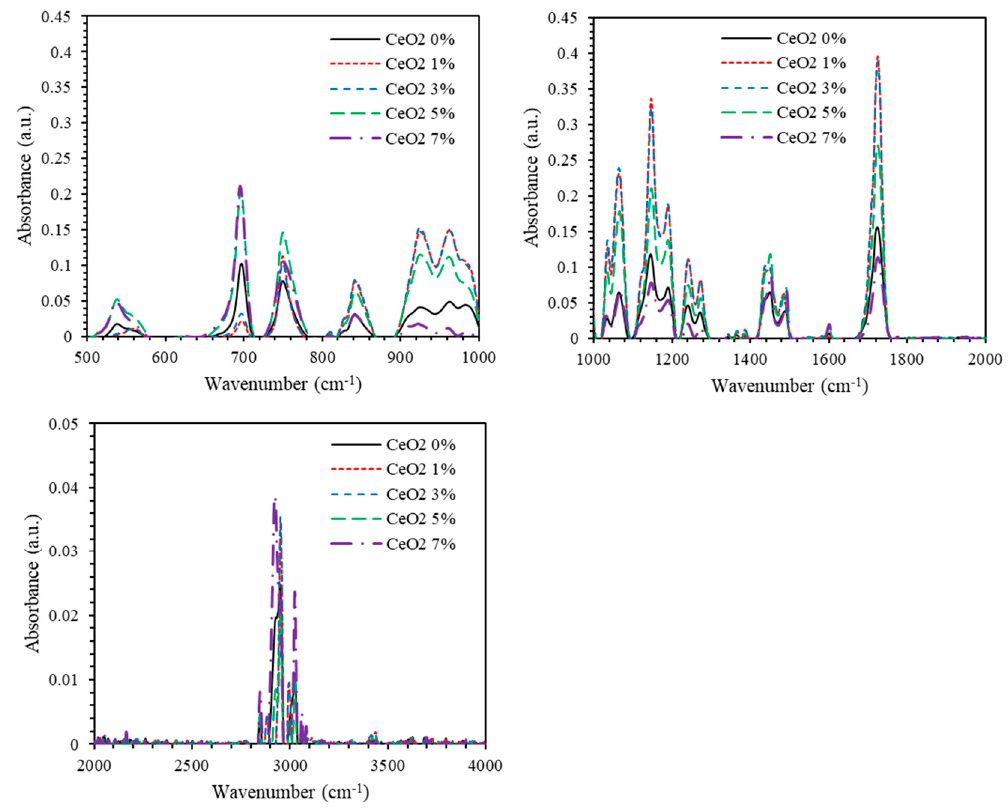
Figure 8. The FTIR spectra of PMMA-PS, and PMMA-PS doped by CeO 2 NPs.